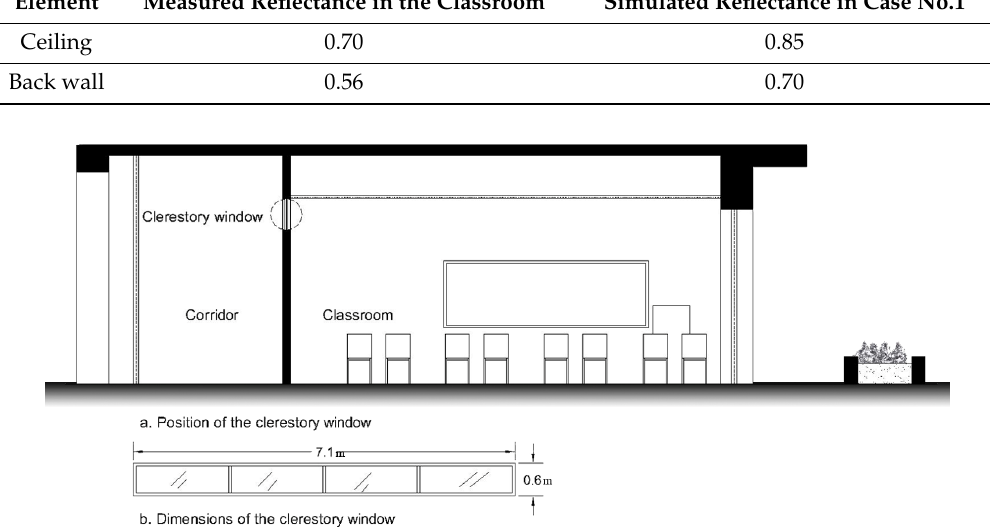
Figure 7. Section of a typical classroom showing the added clerestory window dimensions and position.